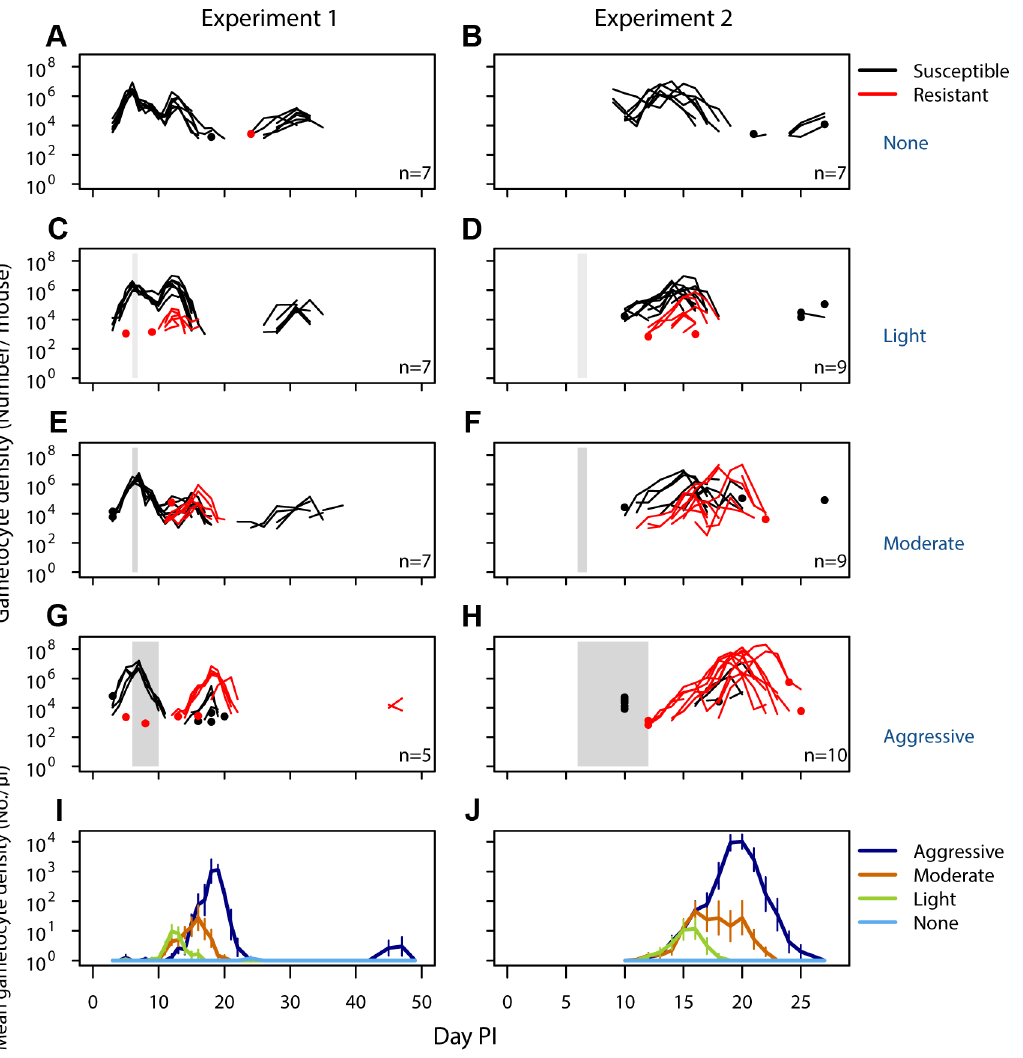
Figure 2. Density of resistant transmission stages increases with drug pressure. Gametocyte (transmission stage) dynamics (top four rows) of individual mice in mixed infections of resistant (red lines) and susceptible (black lines) parasites in experiment 1 (left panels) and experiment 2 (right panels) in infections that received no (A,B), light (C,D), moderate (E,F) and aggressive (G,H) treatment. Dots indicate positive counts detected in individual mice on a single day, grey bars show timing and duration treatment. Bottom row: Mean gametocyte dynamics from experiment 1 (I) and experiment 2 (J) of resistant parasites for each treatment group (legend). Data are means ( 6 s.e.m.) with sample sizes (n, number of mice) as in subplots. Note experiments 1 and 2 have a different duration of the experiment and gametocyte samples were only taken from day 10 onwards in experiment 2.